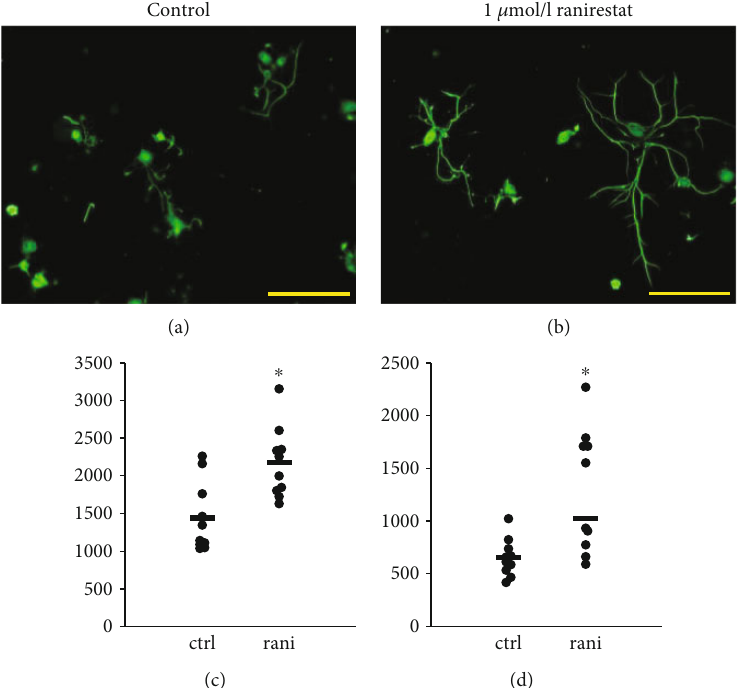
Figure 4: Neurite outgrowth of dorsal rood ganglion (DRG) neurons was elongated by ranirestat. Ranirestat (1 μ mol/l) increased total neurite length in each neuron. (a) Representative fi gure of murine DRG neurons cultured with control medium. (b) Representative fi gure of mouse DRG neurons cultured with 1 μ g/l ranirestat. Scale bar: 200 μ m. (c) Quanti fi ed data of neurite outgrowth in mouse DRG culture. (d) Quanti fi ed data of neurite outgrowth in rat DRG culture. ctrl: control medium; rani: medium supplemented with 1 μ mol/l ranirestat. ∗ p < 0 : 05 versus ctrl. n = 10 in each